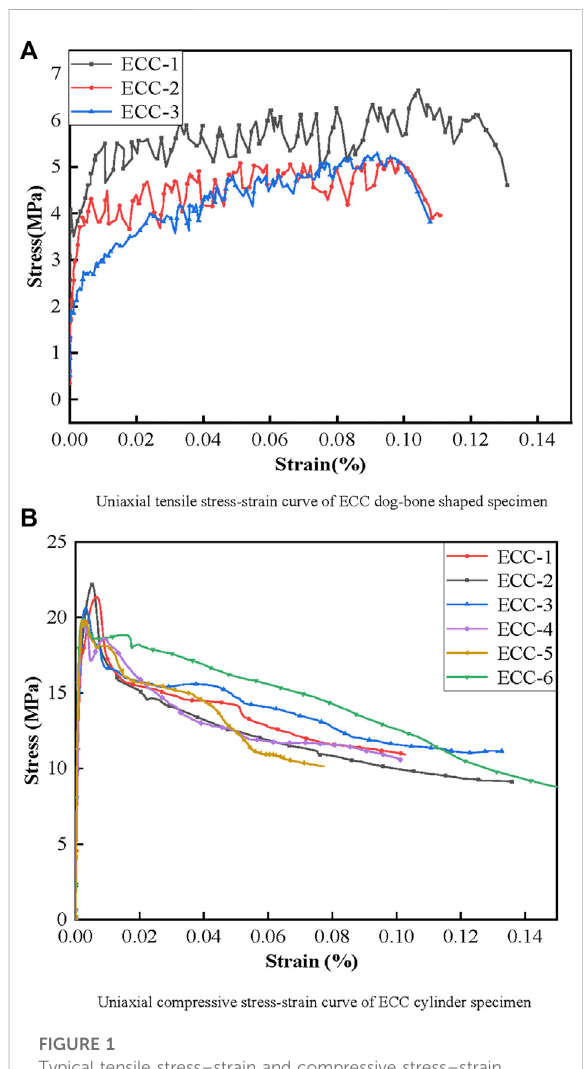
FIGURE 1 Typical tensile stress – strain and compressive stress – strain curves.